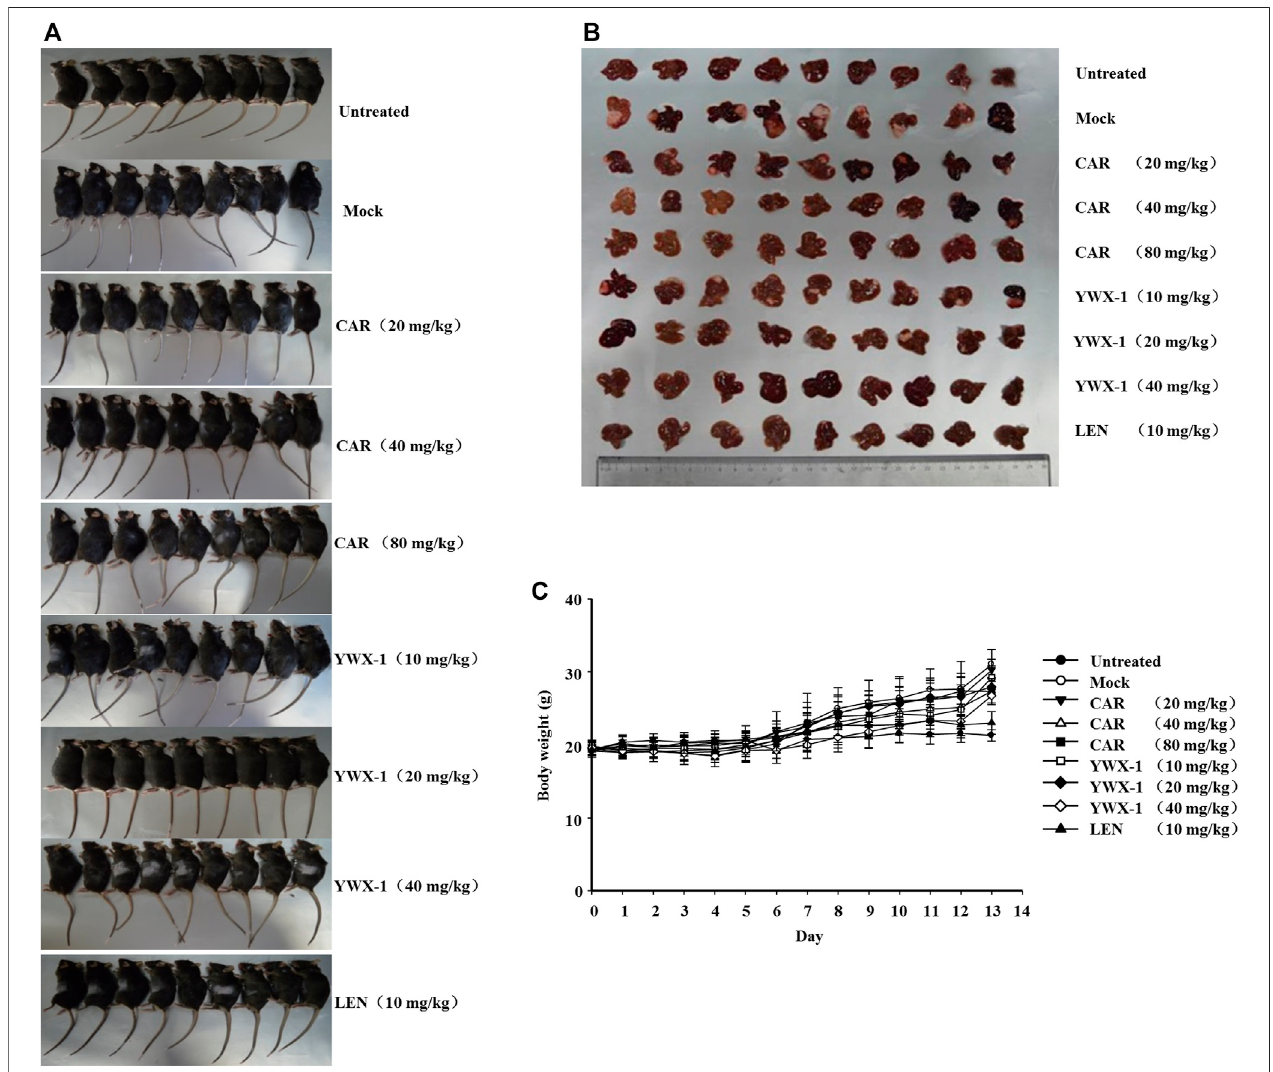
FIGURE 11 | Carrimycin (CAR) and monomeric isovalerylspiramycin I (YWX-1) inhibit the growth of H22 cells in an orthotopic liver transplantation model. (A) Representative images of orthotopic liver transplantation model. (B) The representative tumor was harvested 24 h after the last treatment and the isolated tumors were photographed. (C) The ascites H22 cells were injected into the mouse liver. Bodyweight changes of each group of mice.